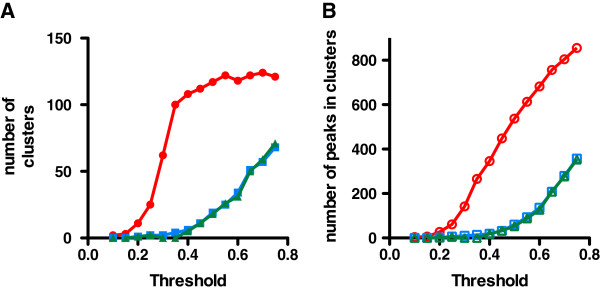
Number of technical clusters and clustered peaks from fractionated plasma dataset as a function of algorithm variance threshold. The Technical Clustering software was applied to a dataset of 1350 peaks from 85 fractionated samples processed in duplicate in a biomarker discovery dataset at the indicated Threshold CV. A) Number of technical clusters using the original table of peaks (closed red circles); peaks randomized within groups simulated data (closed blue squares); and peaks fully randomized simulated data (closed green triangles); B) The number of peaks within technical clusters for the original data (open red circles); simulated data using peaks randomized by sample within groups (open blue squares); and simulated data using peaks fully randomized by sample (open green triangles).